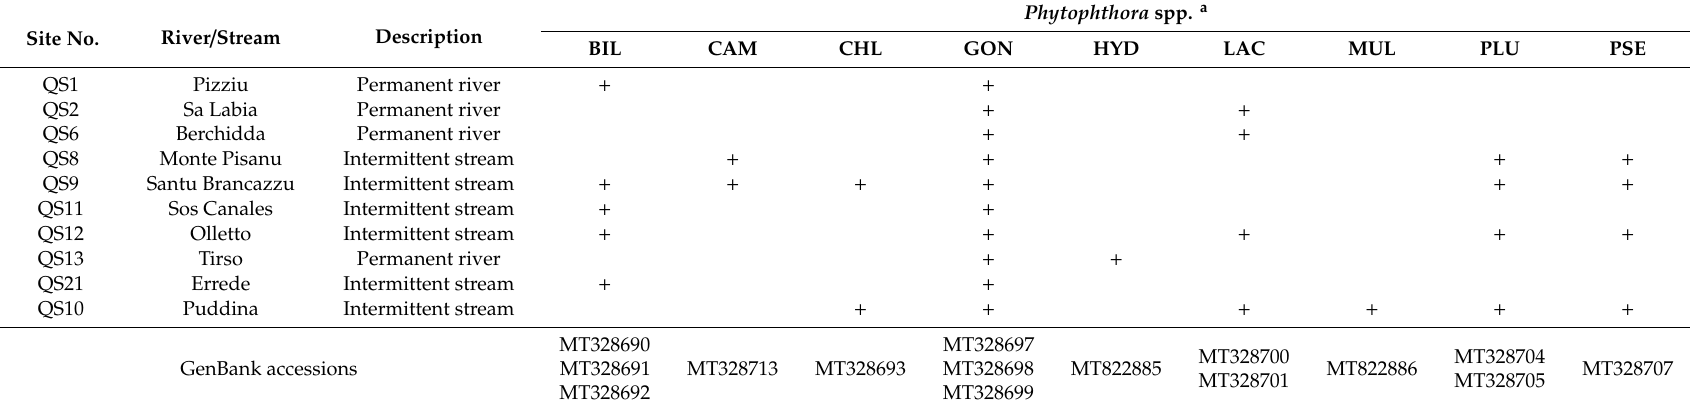
Table 2. Location, name, and typology of the 10 watercourses sampled across declining cork oak stands in Sardinia and Phytophthora taxa identified. Site